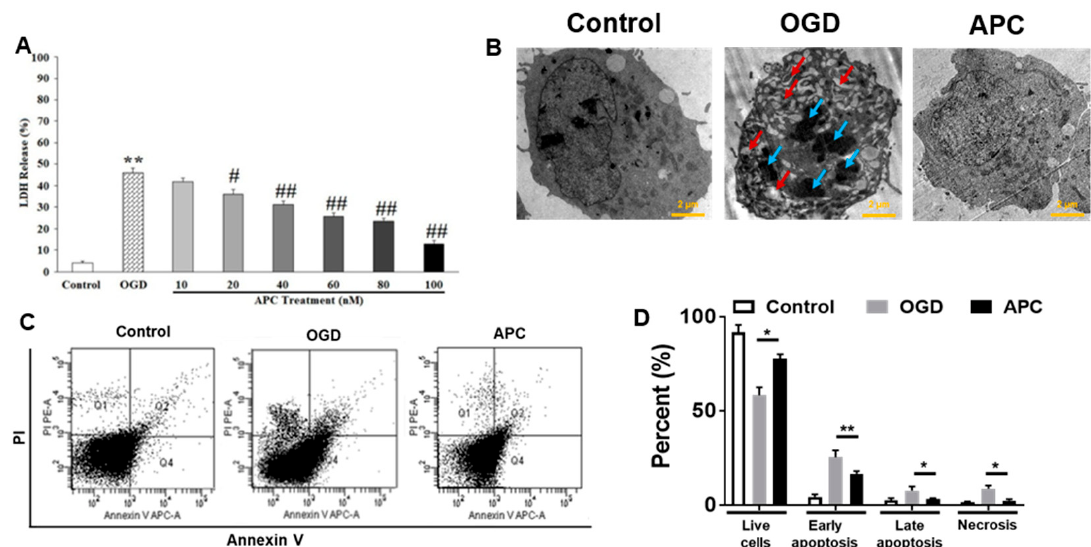
Figure 2. The Dose-dependent activity of activated protein C (APC) on toxicity and ultrastructure changes in SH-SY5Y cells after oxygen-glucose deprivation (OGD) exposure. The dose-dependent activity of APC: SH-SY5Y cells were treated with APC (10–100 nM) during and 24 h after the OGD exposure. ( A ) Effect of APC on lactate dehydrogenase (LDH) release% following OGD, which reveals that APC at 100 nM concentration provides maximum protection. ( B ) Cells were fixed and analyzed by transmission electron microscopy (TEM). Three samples in each group and six fields for each sample were examined. Bars = 2 µ m. ( C ) Cells were stained with annexin V and propidium iodide (PI) 24 h after OGD exposure and then analyzed by flow cytometry. A representative dot plot of sorted cells by flow cytometry for each experimental condition is presented. ( D ) The pooled results of the percentages of live cells, early apoptotic cells, late apoptotic cells, and necrotic cells from three flow cytometry studies are presented. Viable cells = Q3, early apoptosis = Q4, late apoptosis = Q2, and necrosis = Q1. Analyses were done from three independent experiments by one-way ANOVA for the whole group and t-test between two groups. * p ≤ 0.05; ** p ≤ 0.001; # p ≤ 0.005 OGD vs. APC treatment; ## p ≤ 0.001 OGD vs. APC